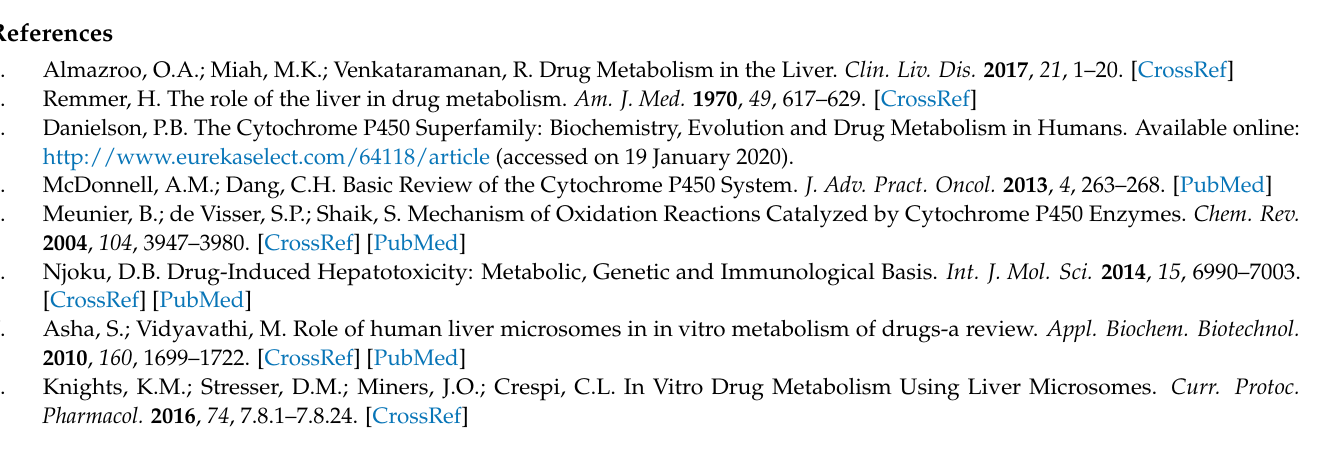
parameter; Table S2: Predicted toxic properties of dapoxetine and its metabolites; Figure S1: MS/MS spectrum and fragmentation pattern of dapoxetine; Figure S2: MS/MS spectrum and fragmentation pattern of M1; Figure S3: MS/MS spectrum and fragmentation pattern of M2; Figure S4: MS/MS spectrum and fragmentation pattern of M3; Figure S5: MS/MS spectrum and fragmentation pattern of M4; Figure S6. MS/MS spectrum and fragmentation pattern of M5; Figure S7: MS/MS spectrum and fragmentation pattern of M6; Figure S8: MS/MS spectrum and fragmentation pattern of M7; Figure S9: MS/MS spectrum and fragmentation pattern of M8; Figure S10: MS/MS spectrum and fragmentation pattern of M9; Figure S11: MS/MS spectrum and fragmentation pattern of M10; Figure S12: MS/MS spectrum and fragmentation pattern of